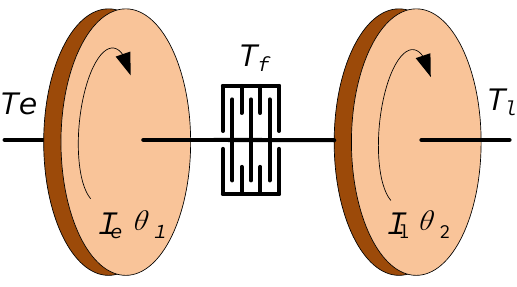
Figure 5. Model of the friction disk rotation of the clutch.